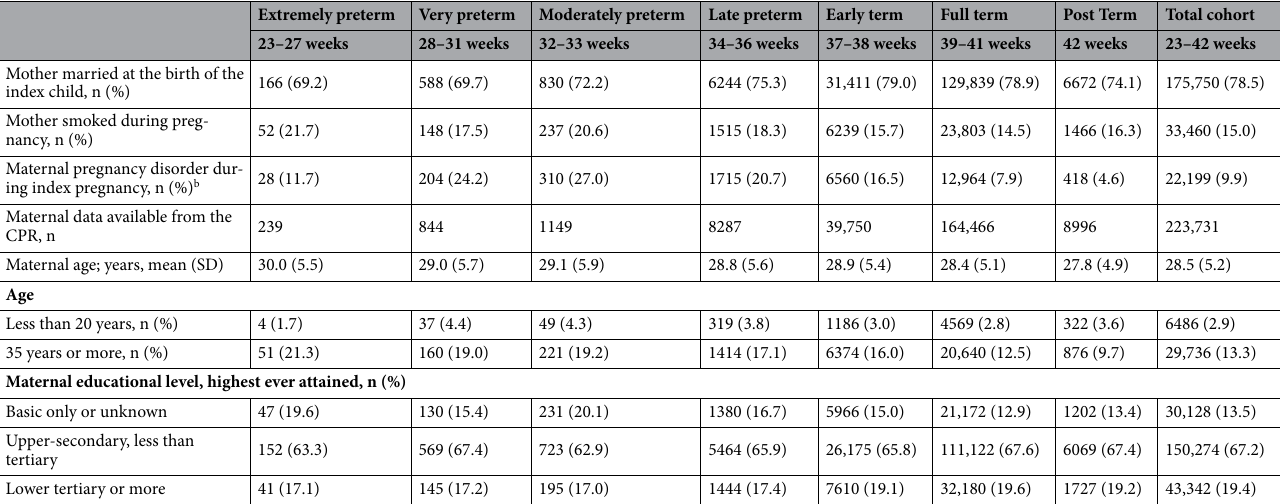
Table 3. Characteristics of the registered fathers of individuals included to the study by GA a category. The amount of missing data was 1.1% (n = 2,530) for paternal age and paternal education. a GA—gestational age. Completed weeks of gestation. b Gestational age categories of 23–31 weeks are combined because privacy regulations prevent us to display cell counts of three or